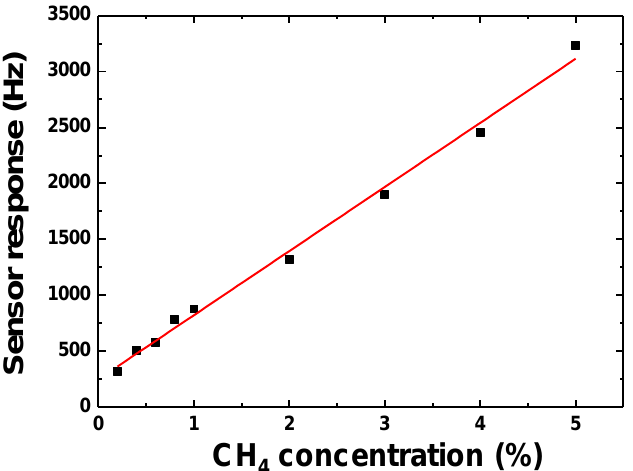
Figure 13. The sensitivity evaluation of the proposed Love wave sensor.